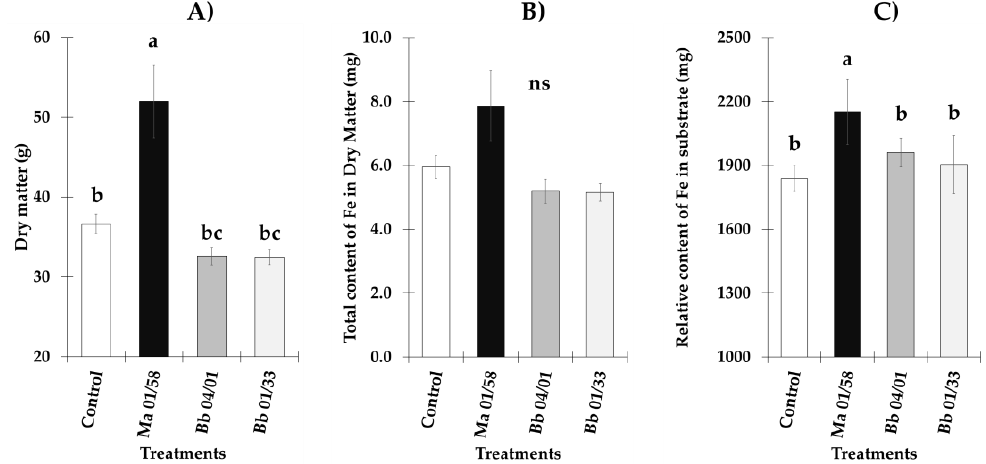
Figure 2. Mean (±SE) of stem and leaves dry matter weight ( A ), total content of Fe in dry matter ( B ), relative content of soluble Fe in substrate ( C ) measured at 50 dpi in melon plants inoculated by soil drenching. Letter over the bars denote significant difference between inoculated and control plants analyzed by completely randomized ANOVA followed by a Tukey test ( p <